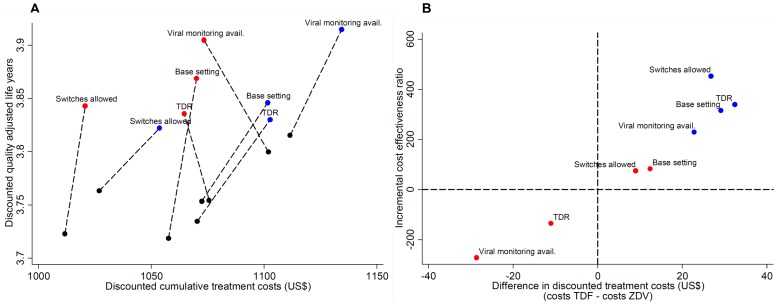

Figure 3A
 plots the average cumulative costs incurred by first-line tenofovir or zidovudine against quality adjusted life years.The connected dots refer to one set of comparisons between first-line tenofovir (TDF; coloured dots) or zidovudine (ZDV; black dots) using different assumptions regarding scenarios of TDF resistance emergence (red dots: base scenario; blue dots: pessimistic scenario involving the emergence of the Q151M multidrug-resistance complex; see Figure 1 for further details), as well as for alternative settings, which were the availability of 6-monthly HIV RNA determinations; >0% prevalence of transmitted drug resistance (TDR) in the study population; or exchange of ZDV with TDF (and vice versa) due to toxic side effects allowed (see Materials S1 for further details). Figure 3B plots estimates for incremental cost effective ratios against estimates for cumulative cost differences between first-line TDF and ZDV use.